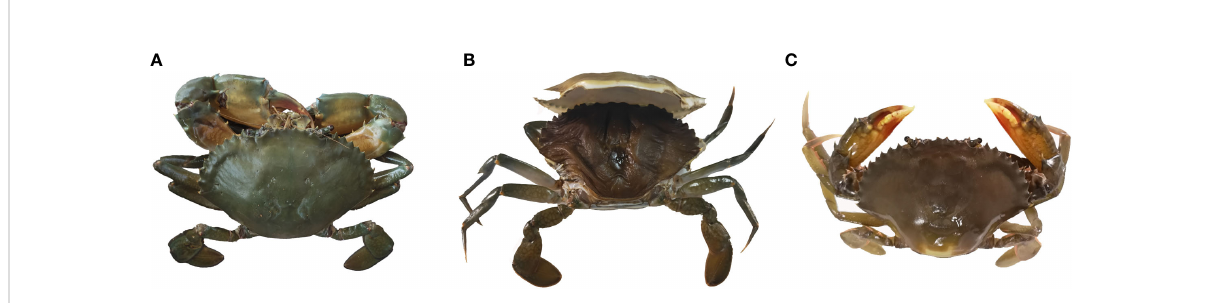
FIGURE 1 Three molt stages of S. paramamosain . (A) intermolt (InM, all parts of the body were hard). (B) premolt (PrM, the old and new carapaces were separated completely). (C) postmolt (PoM, parts of the body were fl accid).